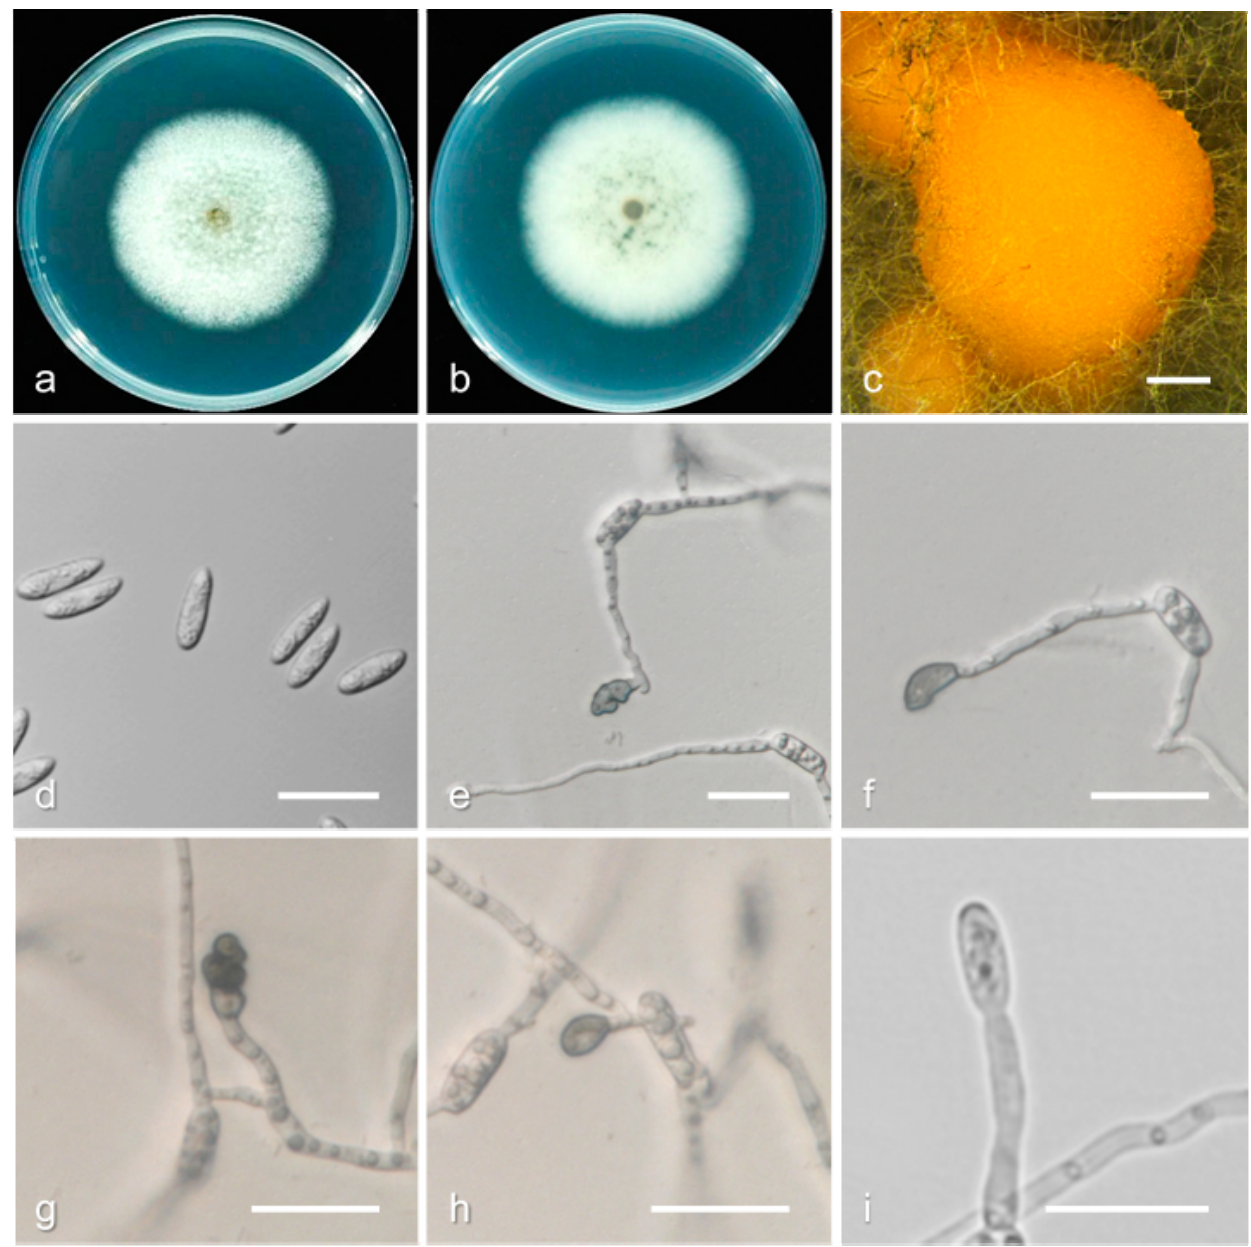
Figure 10. Biological characteristics of Colletotrichum godetiae . ( a , b ) Front and back view of six-day-old PDA culture; ( c ) conidiomata; ( d ) conidia; ( e – h ) appressoria; ( i ) conidiophores (( a – f , i ) isolate YNHH 1-1, ( g , h ) YNHH 9-1). Scale bars: ( c ) = 200 µ m; ( d – i ) = 20 µ m.